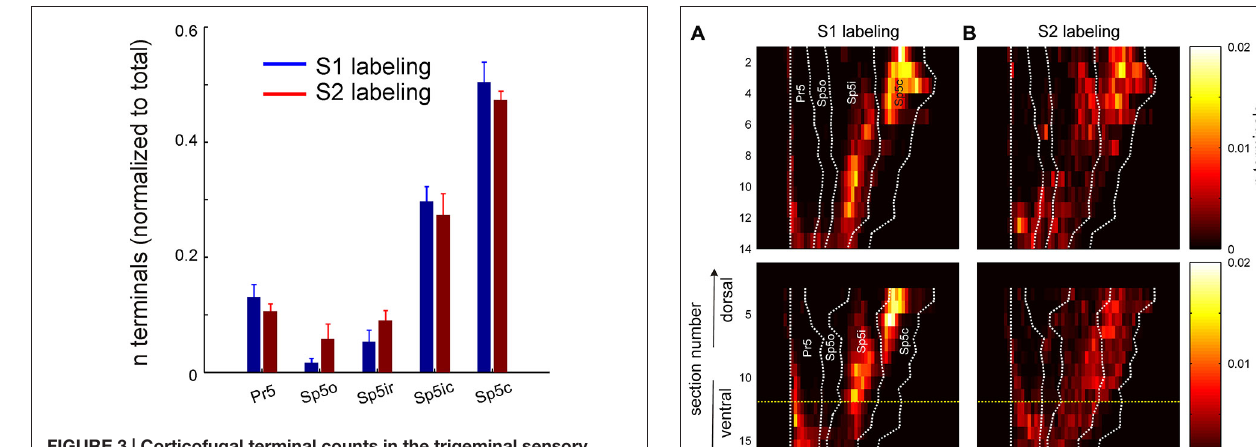
significant for both S1 ( F = 70.22; p < 10e − 6 ) and S2 terminals